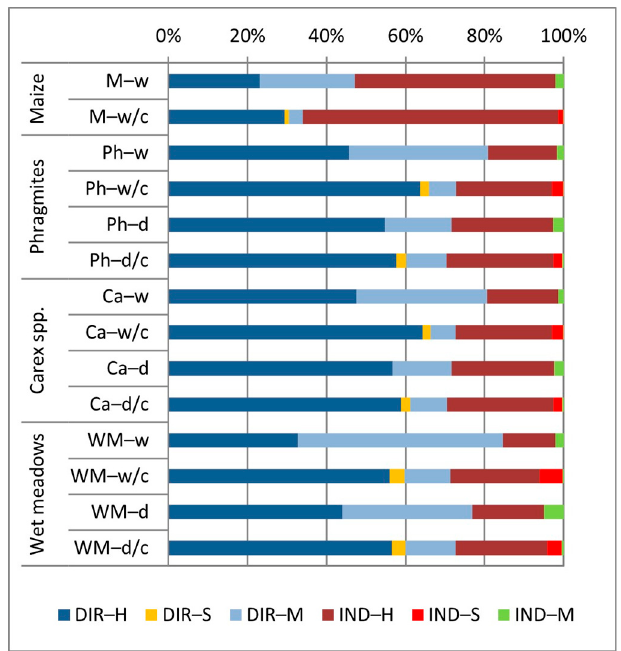
Figure 5. Share of different energy categories in total energy demand; w—wet fermentation, d—dry fermentation, c—separation and composting of digestate; DIR—direct energy input from fuel, IND—indirect energy input; H—cultivation and harvest, S—separation of digestate and composting of solid phase, M—management of digestate/compost.